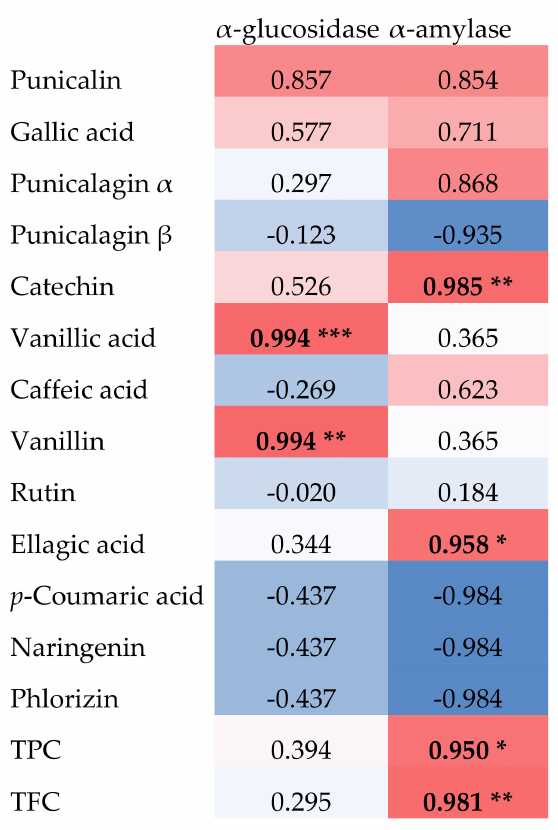
Figure 6. Correlation analysis (Pearson coefficient correlation) linking the phytochemicals and the α -glucosidase and α -amylase inhibition capacities of the extracts from P. granatum bark. *** significant p < 0.001; ** significant p < 0.01; * significant p < 0.05. Color is referred to the relative quantity of each phytochemical from low (blue), medium (white) to high